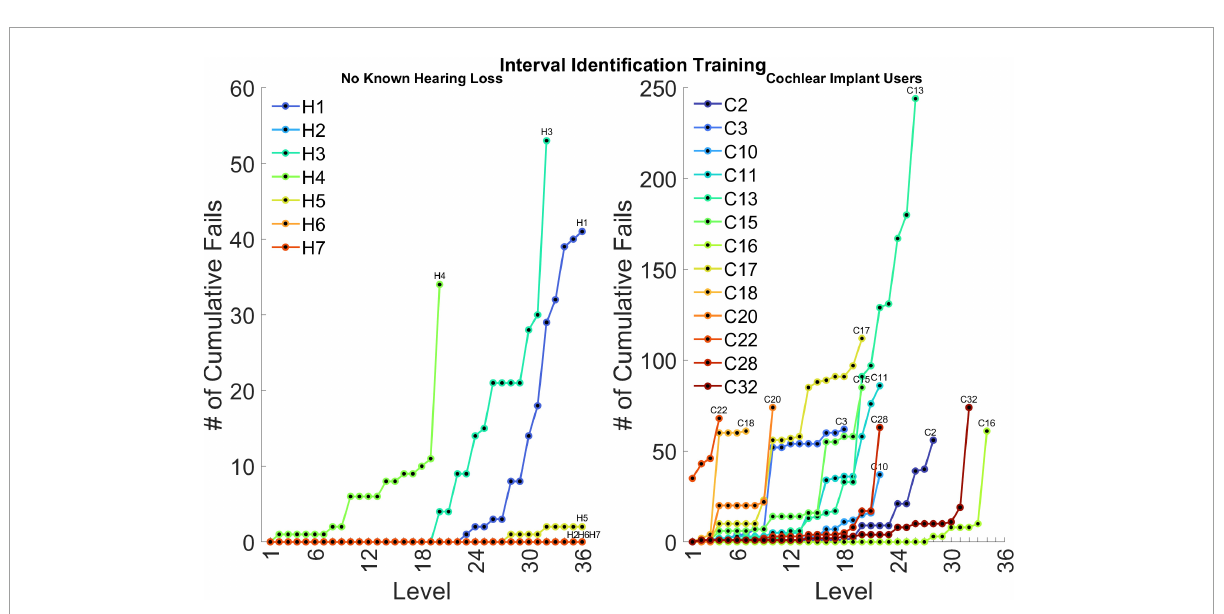
FIGURE9 Number of cumulative failed runs across levels for individual participants. Each line ends when the participant completed 2 weeks of training or reached the final level of the training program. Note, the ordinate has a different scale for the two participant groups. The assessment conditions used for interval identification correspond to training levels of 20, 22, and